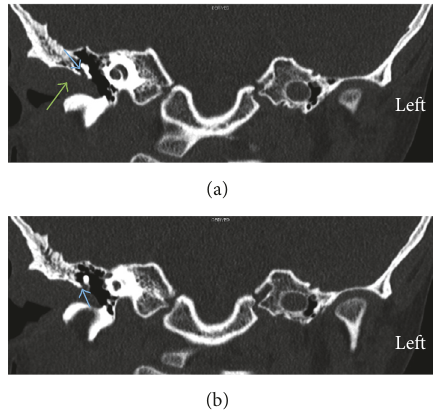
Figure2:CoronalCTscans.(a)Softtissuemassintherightexternal auditory canal (green arrow) extending into Prussak’s space (blue arrow). (b) Minimal erosion of the scutum (blue arrow).